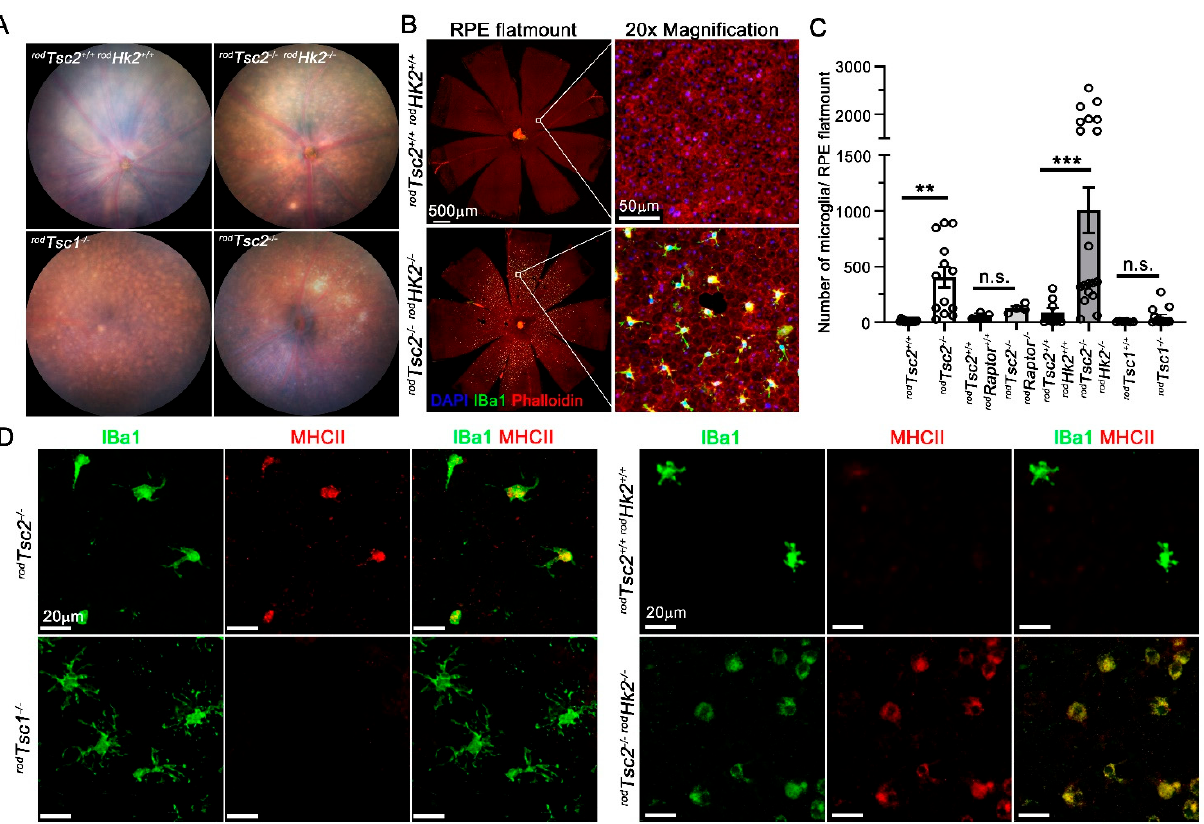
genotypes. To the right: quantifications of relative length at 750 µ m intervals from the optic nerve head in a nasal–temporal direction (value “0” represents optic nerve head). ( H ) Scotopic and photopic ERG measurement of both rod Tsc2 +/+ rod Hk2 +/+ (black bar) and rod Tsc2 − / − rod Hk2 − / − (white bar) mice. Bars show average a-wave amplitude ( µ V) ± S.E.M. ( n = 9 and 11 mice, respectively). Scotopic recordings were performed at 0.1 cd.s/m 2 . Photopic ERG recordings used a background intensity of 9 cd.s/m 2 and a flash intensity of 10 cd.s/m 2 .